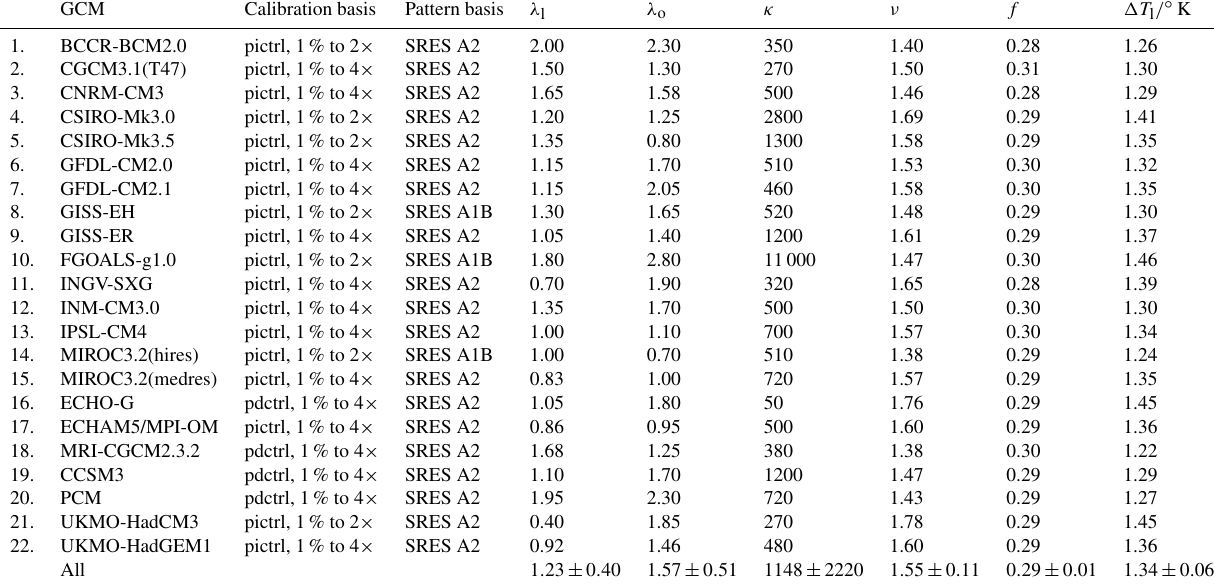
Table 2. Calibration parameters of the simple IMOGEN energy-balance model, for each considered global circulation model. The first column presents which runs (experiments) were used to derive the parameters, listed as follows: (i) an ocean effective thermal diffusivity which determines the uptake of energy, κ (Wm − 1 K − 1 ); (ii) a constant ratio of mean land and ocean surface (sea surface temperature, SST) rate of warming, ν ; (iii) climate sensitivity over land λ l and (iv) ocean λ o (Wm − 2 K − 1 ); and (v) f , which is a land fraction, including Antarctica. The last column presents GCM-specific ratios of warming aver all land per degree of global